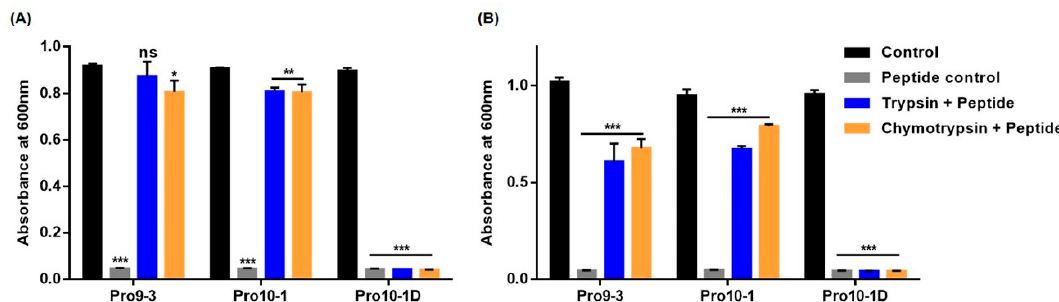
Figure 6. Inhibition of antimicrobial activity of peptides by trypsin and chymotrypsin assessed using the broth microdilution method: peptides at their respective minimum inhibitory concentrations were preincubated with trypsin and chymotrypsin for 6 h, and the treated peptides were examined for their antimicrobial activity against ( A ) E. coli and ( B ) A. baumannii for 16 h. Inhibited bacterial growth signifies the proteolytic stability of peptides. Data are shown as the mean ± SEM of three independent experiments and are statistically significant at * p < 0.05, ** p < 0.01, and *** p < 0.001; ns, not significant (by one-way ANOVA , Tukey’s post hoc test ).